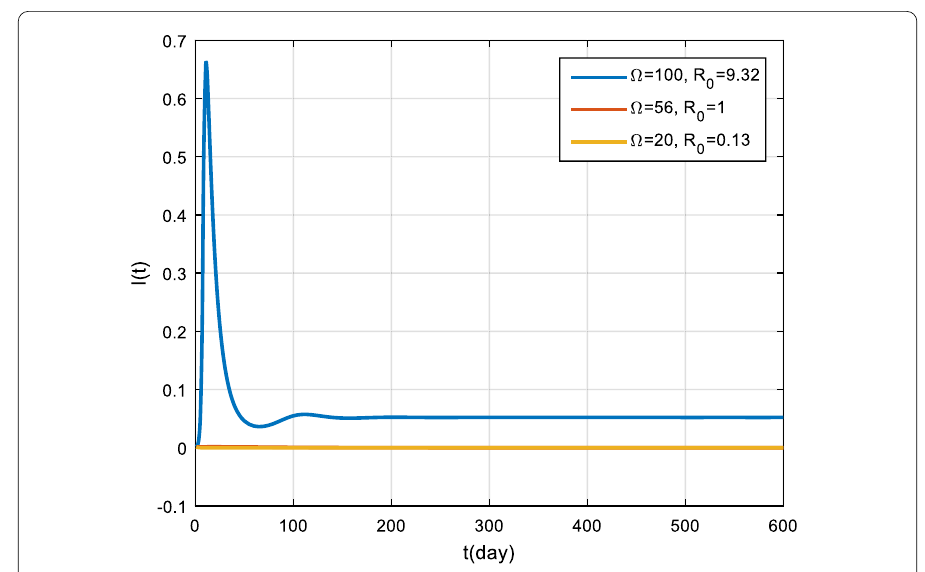
Figure 6 Variation in the number of infected population for different values of (cid:7)